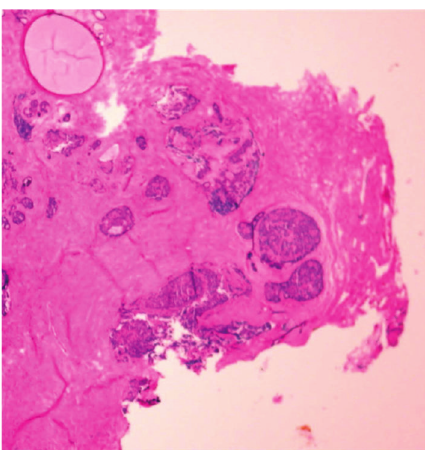
Figure 8: Frozen section slide showing thermal artifact, which obliterates microscopic details that a pathologist needs to diagnose carcinoma. The area bottom center on the edge of the tissue is ductal carcinoma in situ that has been transected in a